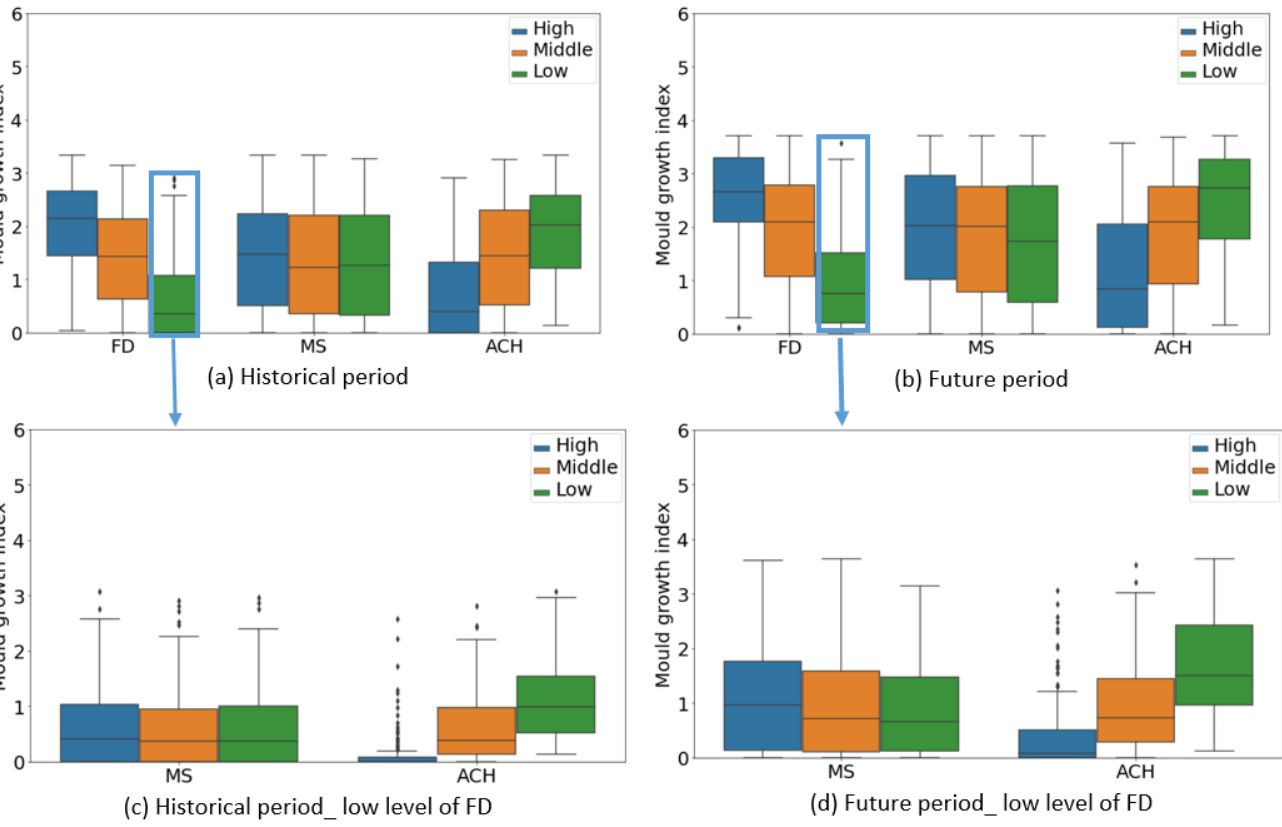
Figure 17. Boxplots of 2-year’s averaged mould growth index at different levels of mould growth risk control variables. FD: Rain deposition factor; MS: Rain leakage moisture source; ACH: Cladding ventilation rate. For ACH, the high level is the 4 opening ventilated design, the middle level is the 2 opening ventilated design and the low level is the vented cavity which has no opening on the top. The marks of “ ⧫ ” are outliers.